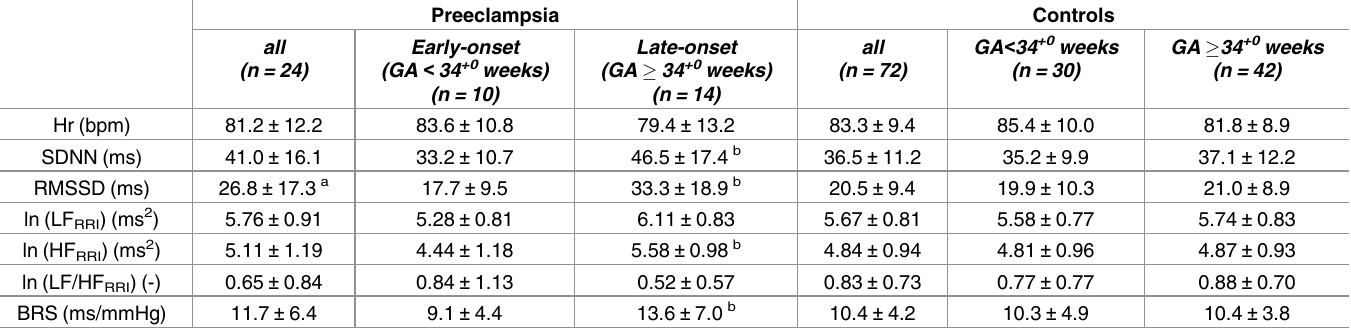
Table 2. Heart rate variability indexes (standard deviation of normal-to-normal beat (SDNN) and root mean squared successive differences of R-R intervals (RMSSD)) and baroreceptor reflex sensitivity (BRS) in preeclampsia groups vs.